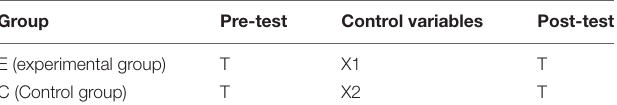
TABLE 2 | Research design.